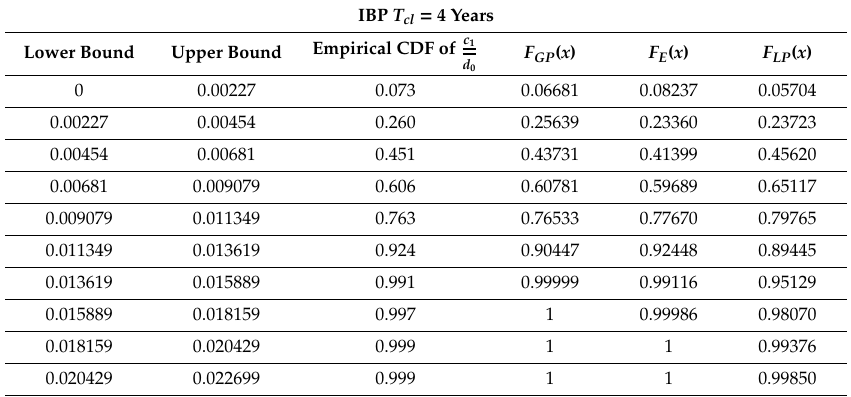
Table 6. The empirical values and the values of cumulative density functions (CDF) for the three best fitted distributions for c 1 with respect to d 0